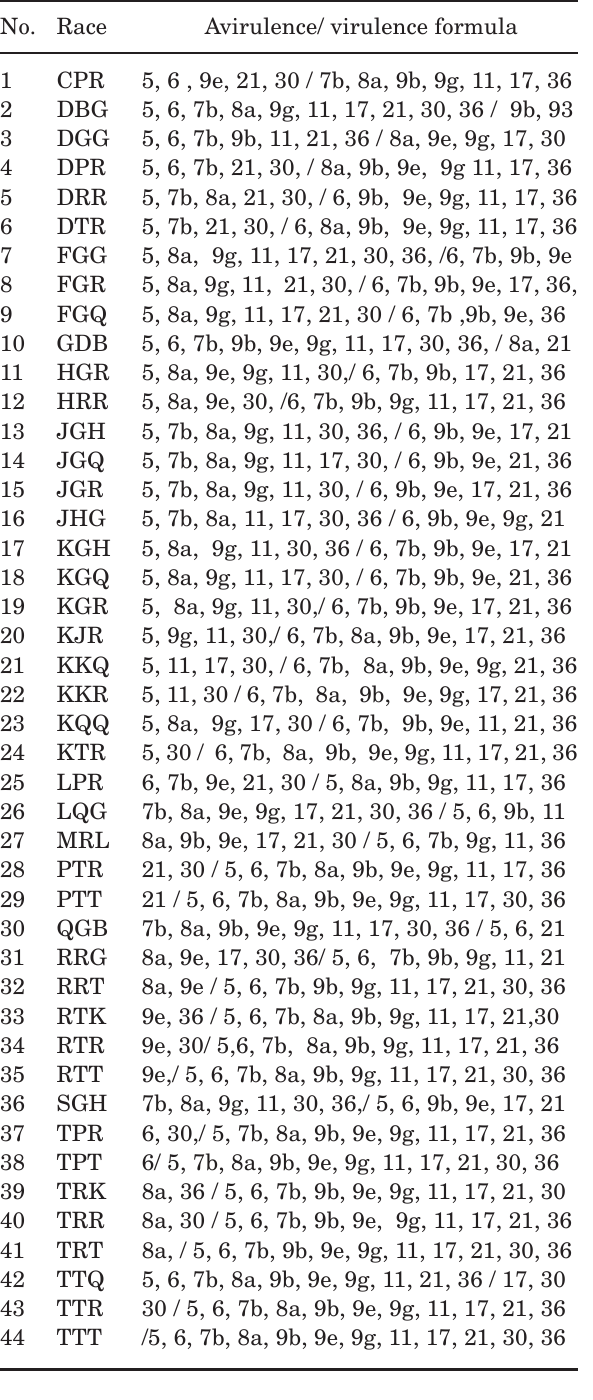
Table 7. Avirulence/virulence formula for 44 pathotypes of Puccinia graminis f. sp . tritici identified in Ethiopia on the twelve wheat stem rust standard differential